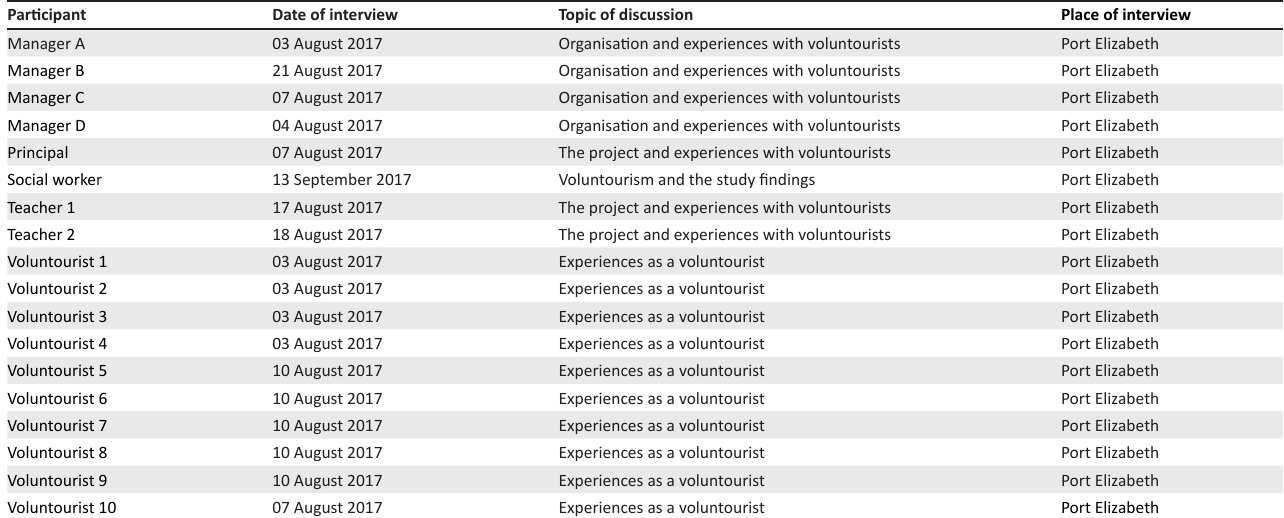
TABLE 1: Interview